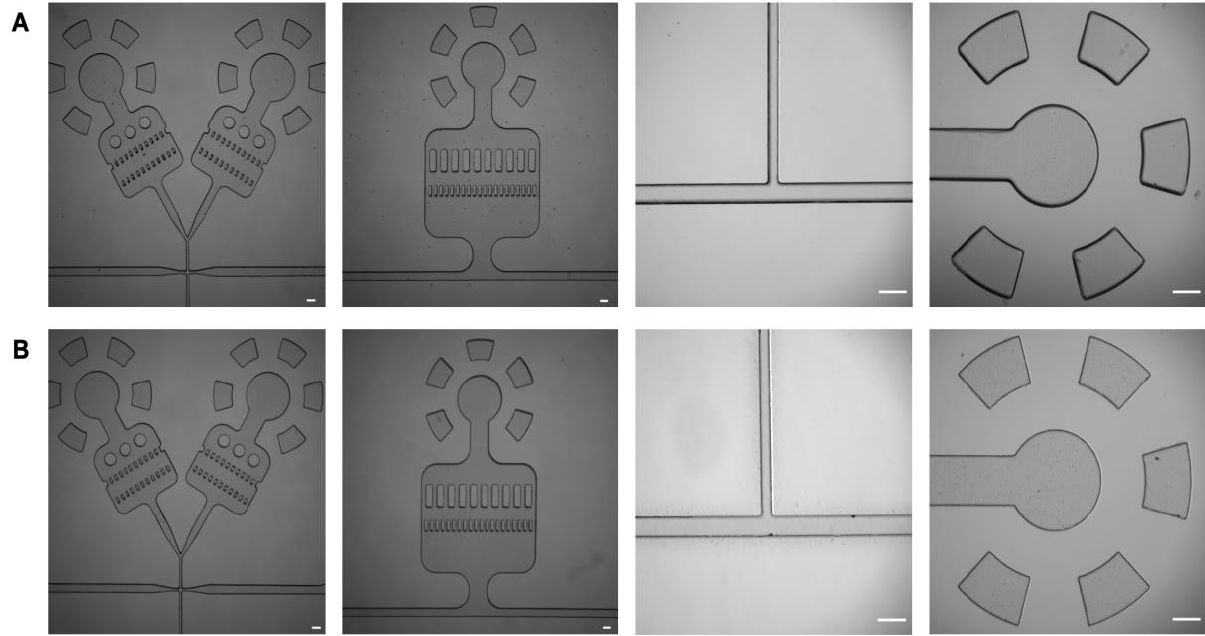
Figure 3. PDMS droplet microfluidic devices. ( A ) Images of DUV Light System wafer patterns, including PDMS flow focusing and T-junction microfluidic devices. ( B ) Images of ABM 3000HR mask aligner wafer patterns, including PDMS flow focusing and T-junction microfluidic devices. (Scale bar = 150 µm).